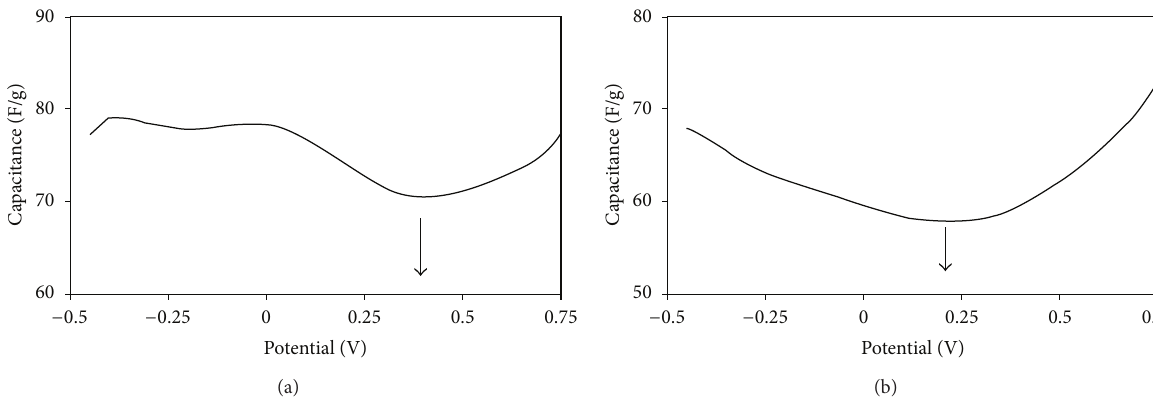
Figure8:Potentialcapacitancecharacteristics.Capacitancemeasuredatdifferentappliedpotentialin0.1 MNaFaqueoussolutionfordifferent materials, (a) unreduced, (b) reduced